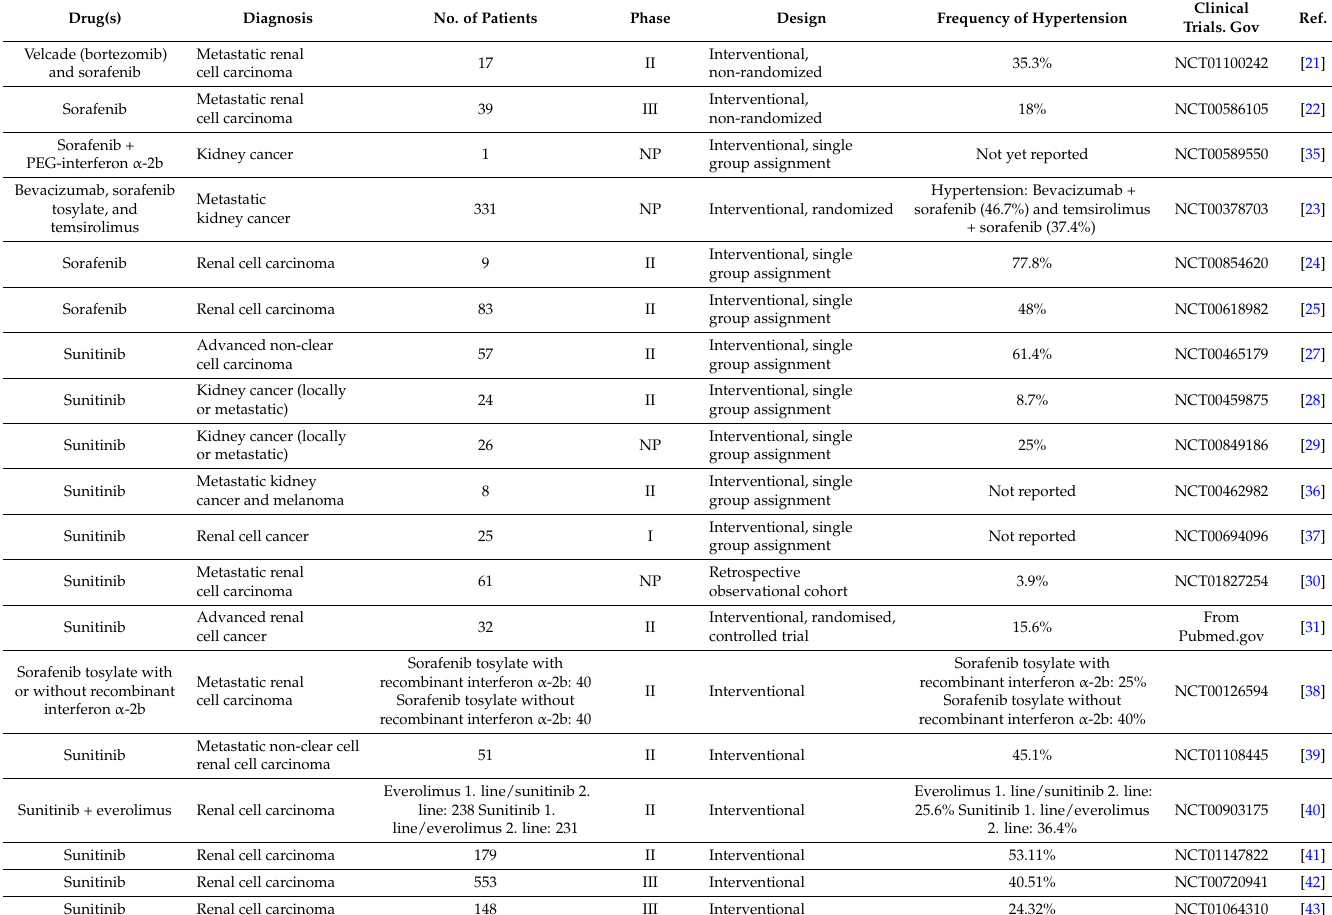
Table 2. Overview of clinical trials last updated from January 2015 to December 2016 of sorafenib and sunitinib, according to https://clinicaltrials.gov, with focus on frequency of hypertension.